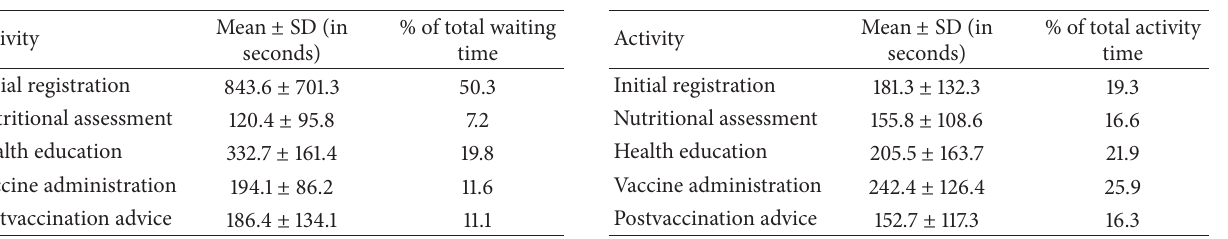
Table 1: Waiting time at different service delivery points ( 𝑛 = 863 ). Table 2: Service delivery time at different activity points ( 𝑛 = 863